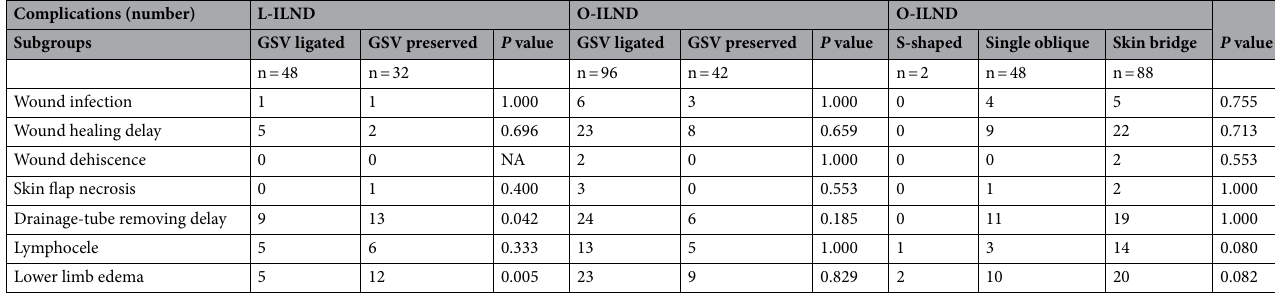
Table 4. Subgroup analysis Complications reported in the patients receiving GSV preservation and GSV ligation. GSV great saphenous vein, n number, L‑ILND laparoscopic inguinal lymph node